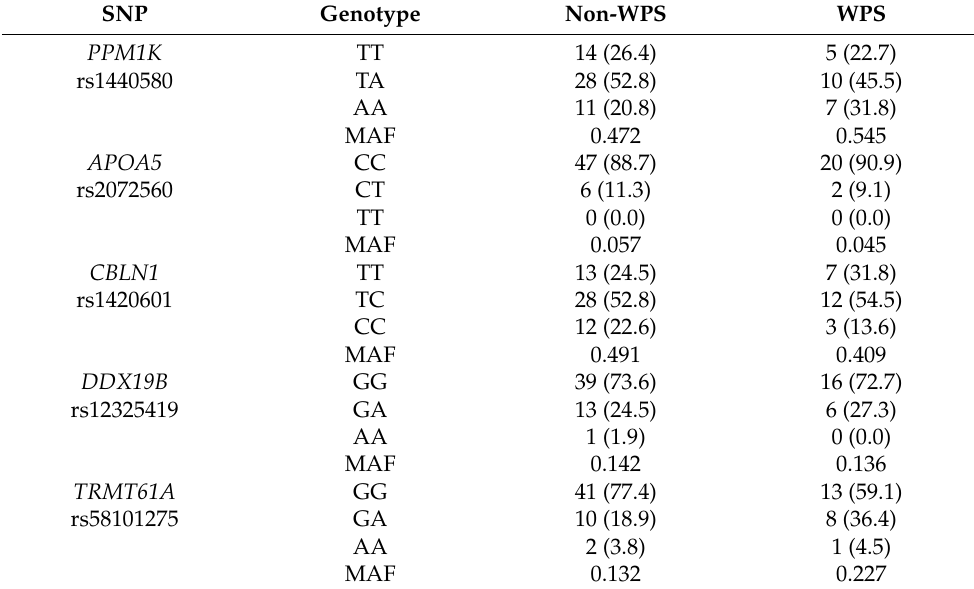
Table 3. Genotype distribution for all